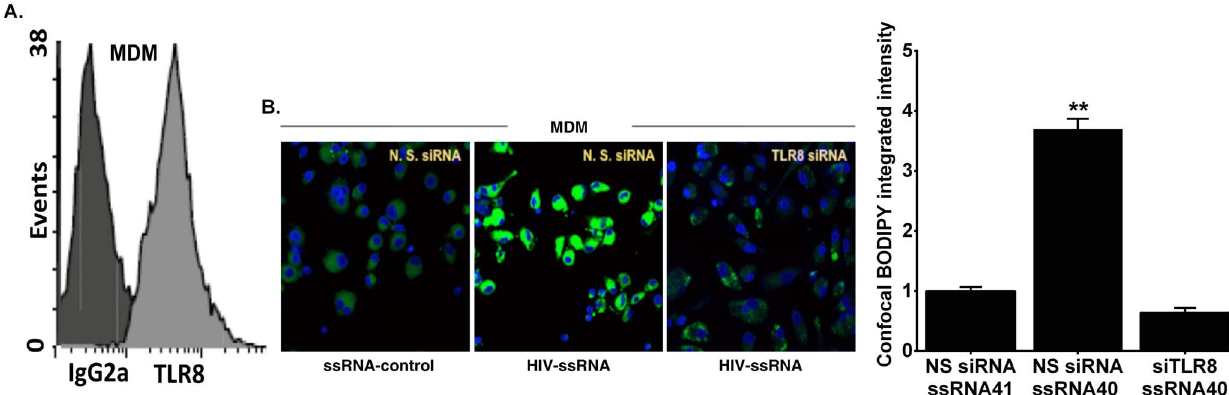
Figure 6. Dependence of foam cell formation in MDMs on TLR8 activation by HIV ssRNA. ( A ) Intracellular expression of TLR8 in MDMs. MDMs which were incubated with PE-conjugated anti-TLR8 or isotype antibody control. Intracellular expression was determined by flow cytometry. Representative profiles were similar in four independent experiments (n=4 subjects). ( B ) Functional silencing of human TLR8 leads to diminution of foam cell formation in MDMs. BODIPY staining of MDMs after pretreatment with TLR8 siRNA or nonsilencing control. Cells were challenged with HIV ssRNA or ssRNA control for 24 h. Bar graph shows integrated fluorescence intensities of BODIPY per cell of the confocal micrographs. Results are representative of four independent experiments with similar results. **p , 0.01 compared to NS siRNA + ssRNA41 control.